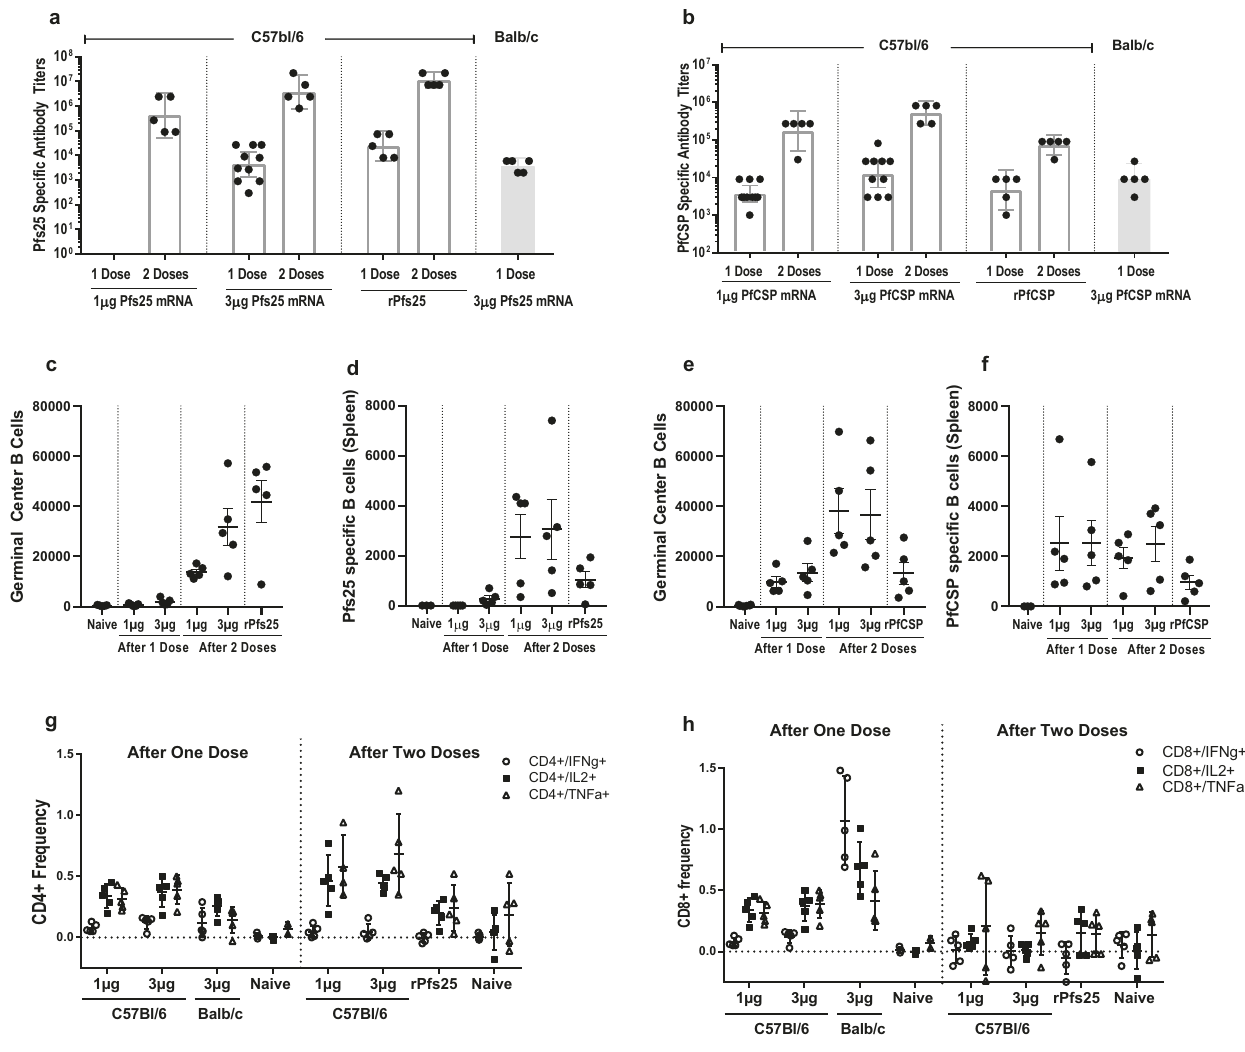
Fig. 9 Evaluation of cellular responses in mice immunized with Pfs25 and PfCSP mRNA-LNPs. Groups of C57Bl/6 and Balb/c mice ( N = 5) were immunized with 1 μ g and 3 μ g of either Pfs25 or PfCSP mRNA-LNPs following one or two immunizations. Additional groups were immunized with two doses of 10 μ g of rPfs25 and rPfCSP formulated with Alhydrogel, as positive controls. a Anti-Pfs25 antibody responses, and b Anti-PfCSP antibody responses evaluated by ELISA are reported as the geometric mean endpoint titers with 95% con fi dence intervals. Germinal center B (GCB) cells and antigen speci fi c B cells were quanti fi ed by fl ow cytometry. The reagents used are found in Supplementary Table 1. and the gating strategy is reported in Supplementary Fig. 1. Panels c and d show quanti fi cation of GCB cells and Pfs25-speci fi c B cells respectively in Pfs25 mRNA-LNP immunized mice. Panels e and f show the quanti fi cation of GCB cells and PfCSP-speci fi c B cells, respectively in PfCSP immunized mice. Additionally for the Pfs25 immunized mice, the harvested splenocytes were stimulated with a pool of overlapping peptides of Pfs25 for 6 h and assessed by fl ow cytometry for T cell responses. The frequency of stimulated cytokine-producing T cell subpopulations is reported. Panel g shows CD4 T cell responses and panel h shows the CD8 T cell responses. Error bars for panels ( c-h ) represent the standard error of the